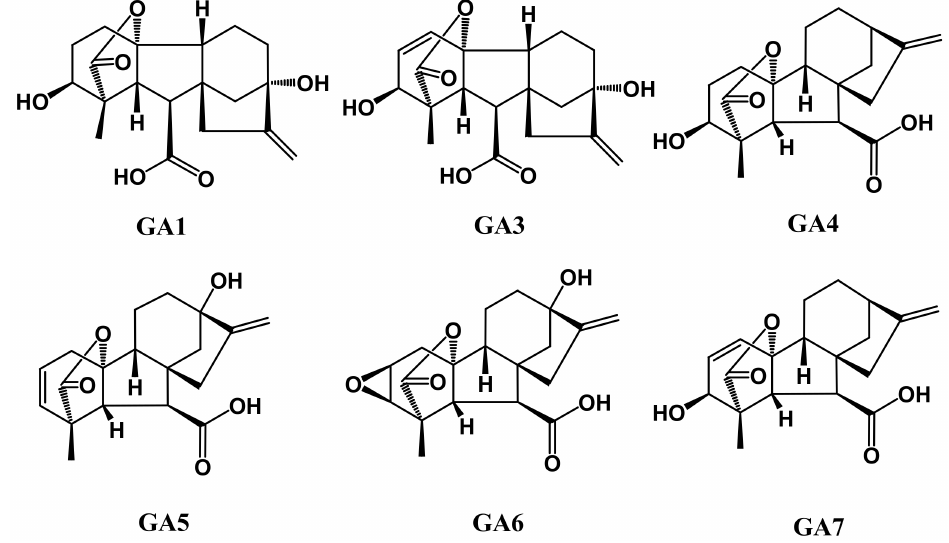
Figure 4. Structures of gibberellic acid